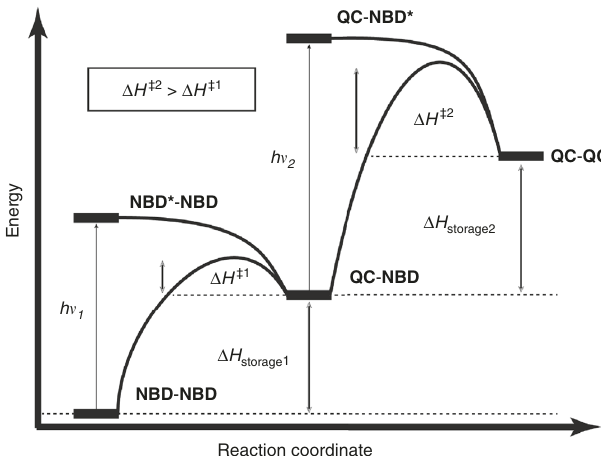
Fig. 2 Energy diagram. Schematic representation of the difference in half- life and irradiation energy for the two switching